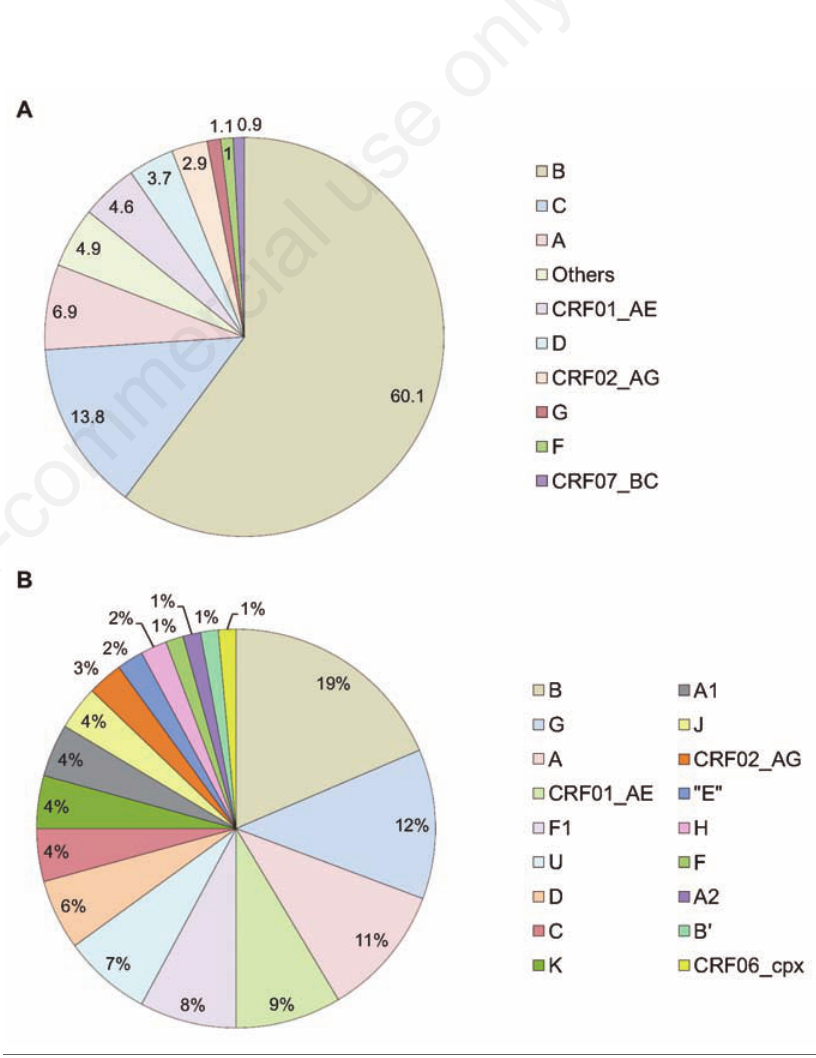
Figure 1. Worldwide distribution of HIV-1 recombinant forms. (A) Frequency of recom- binant forms that contributed towards total HIV infections as of the year 2012. (B) Frequency of different recombinant forms that contributed towards 55 CRFs identified to